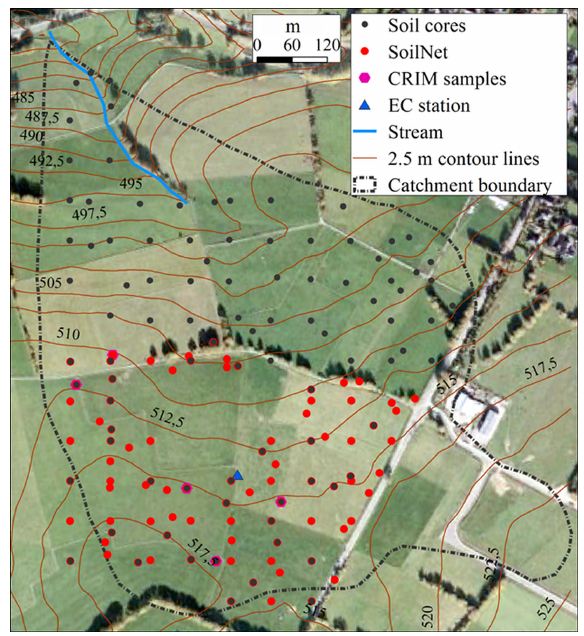
Figure 1. Map of the Rollesbroich catchment showing locations of the SoilNet sensor network, locations of the soil samples to de- termine soil physical and chemical properties, locations of the soil samples for site-specific calibration of the CRIM model, the loca- tion of the eddy covariance (EC) station, 2.5m contour lines, and catchment boundary.